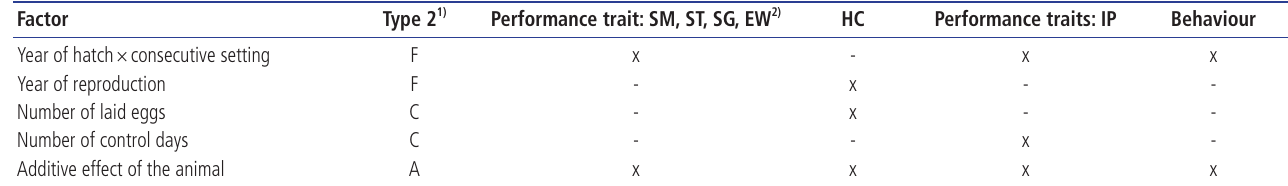
Table 3. Factors in the calculation models for each trait Factor Type 2 1) Performance trait: SM, ST, SG, EW 2) HC Performance traits: IP Behaviour